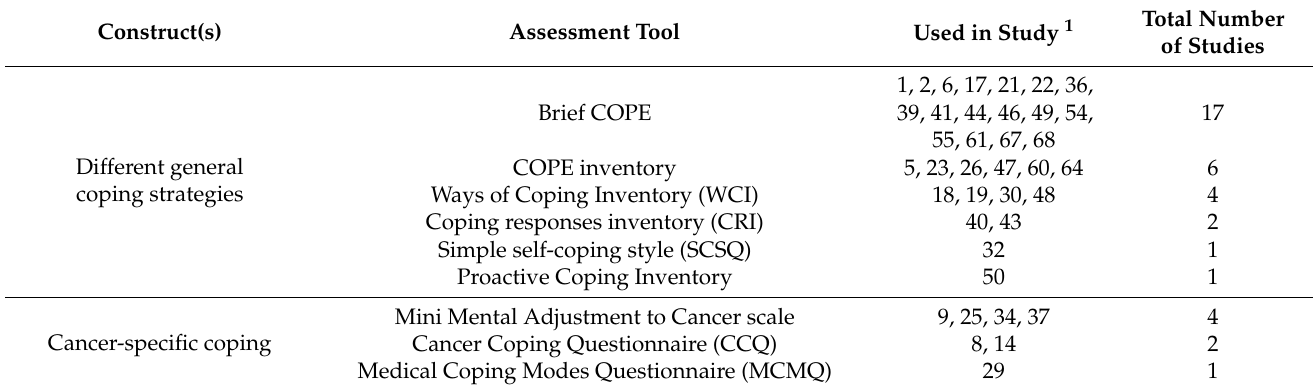
Table 3. Assessment tools for coping strategies (self-reported